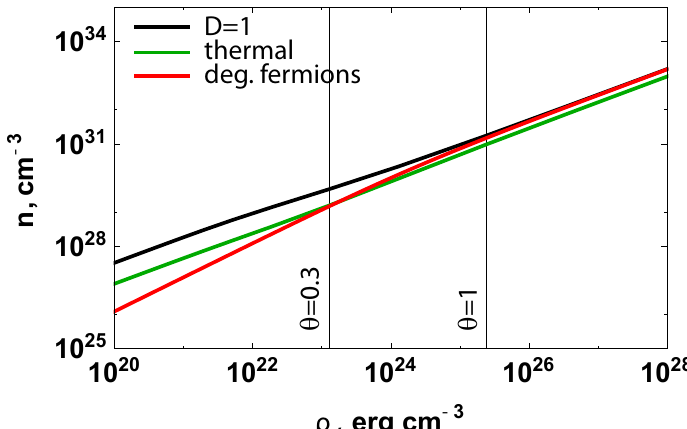
Figure 1. Number density-energy density diagram of a photon–electron–positron plasma. Green curve corresponds to thermal equilibrium state. Black curve shows the transition from nondegenerate D > 1 to degenerate D < 1 plasma, where D is defined by Equation (2). Red curve corresponds to fully degenerate pair state defined by Equation (3). Vertical line on the left corresponds to the transition from nonrelativistic to relativistic pair plasma ( θ = 0.3). Vertical line on the right corresponds to relativistic pair plasma with θ =